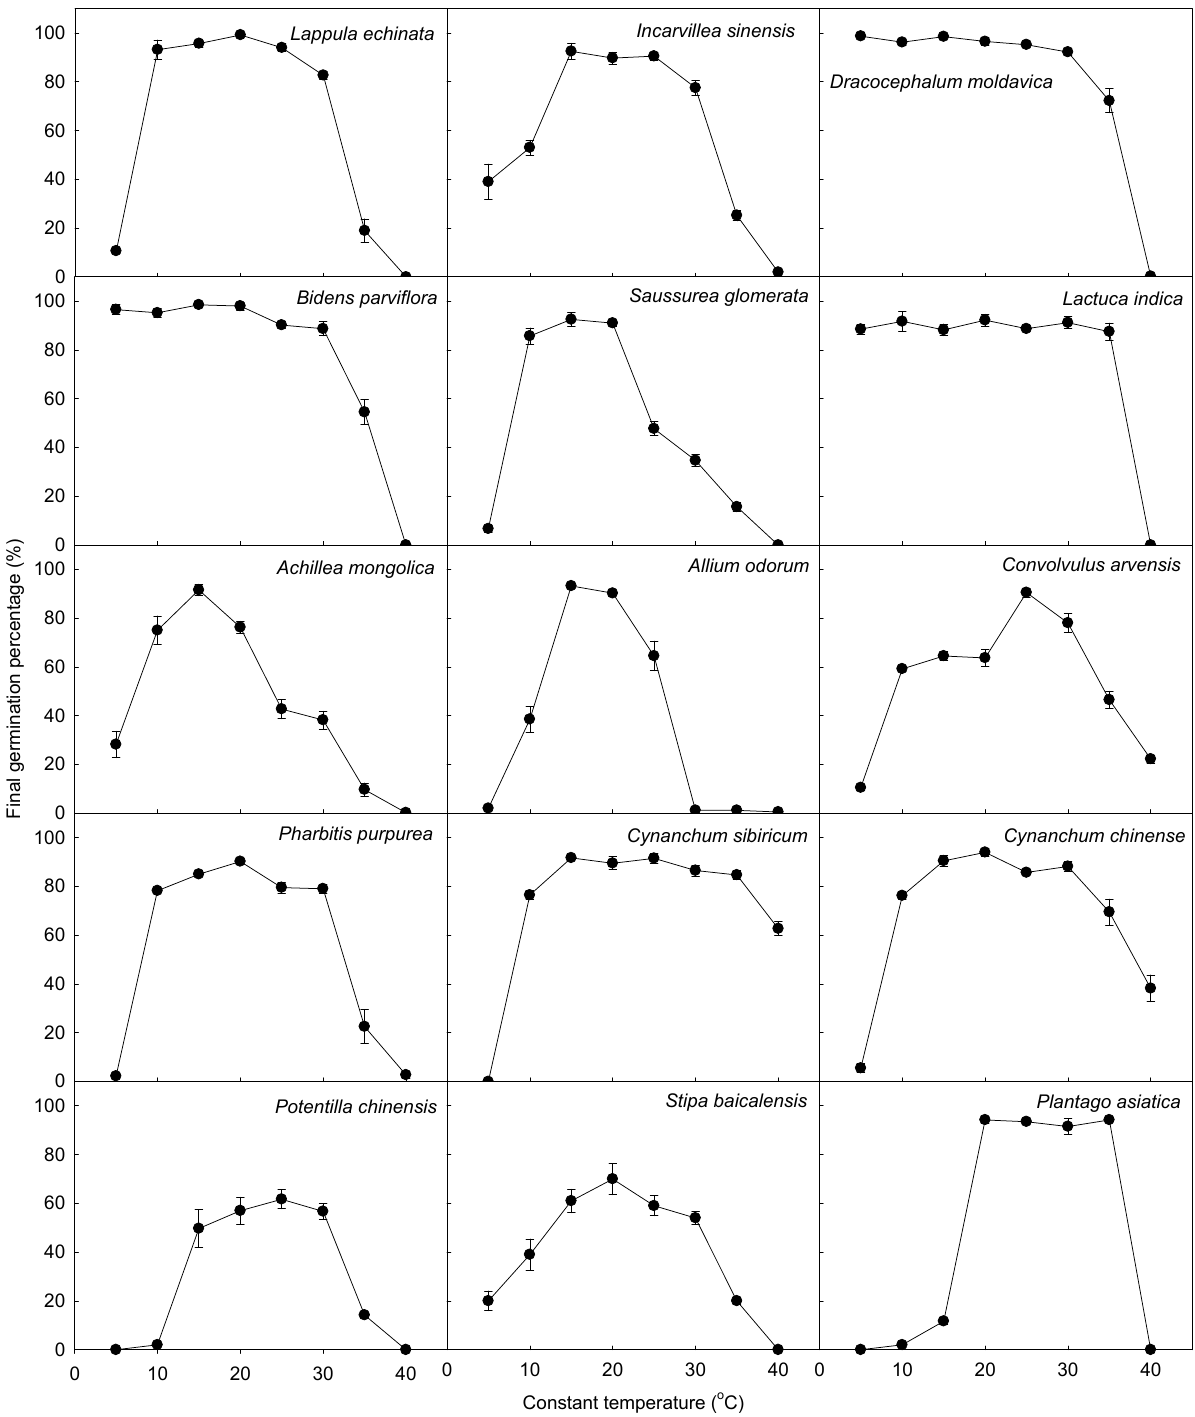
Figure 2. Final germination percentages of C 3 species at a range of constant temperatures from 5 °C to 40 °C Bars represent ±SE ( n =